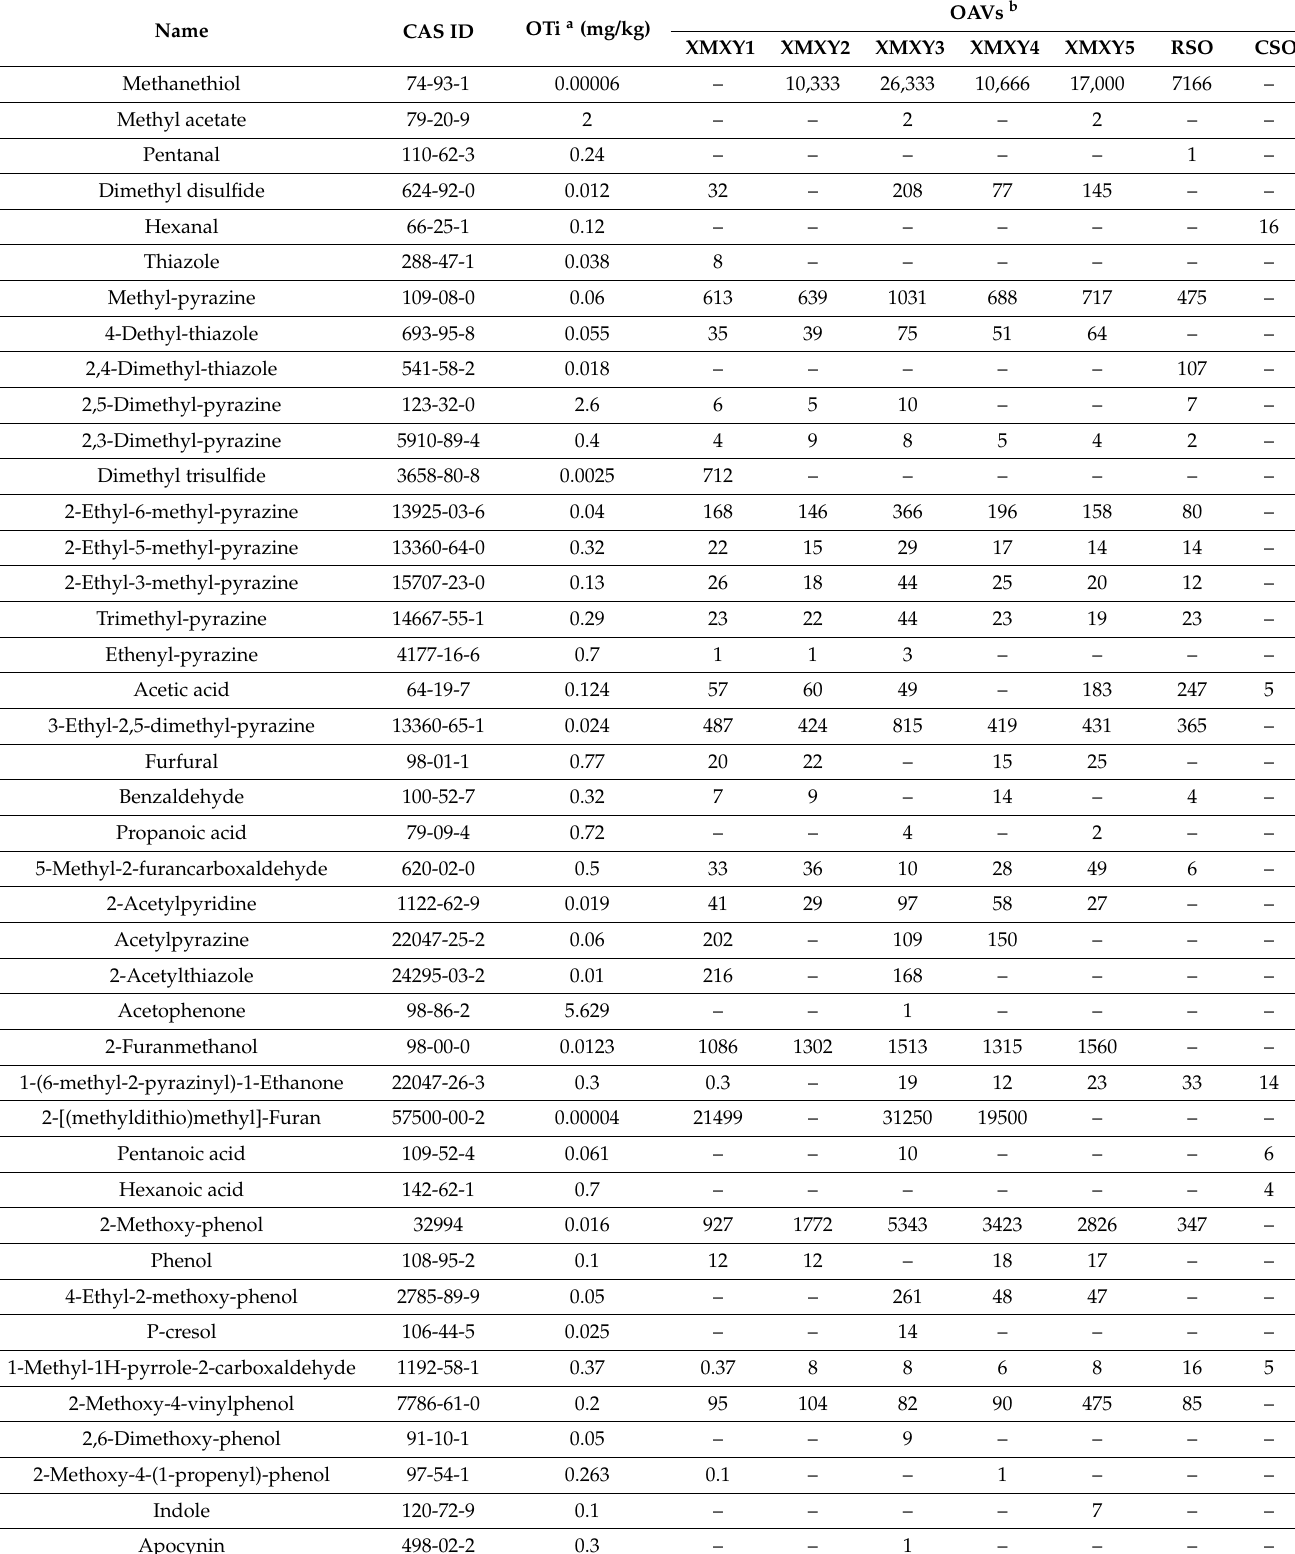
Table 1. Odor thresholds and OAVs of the compounds in XMXY1–5, RSO, and CSO